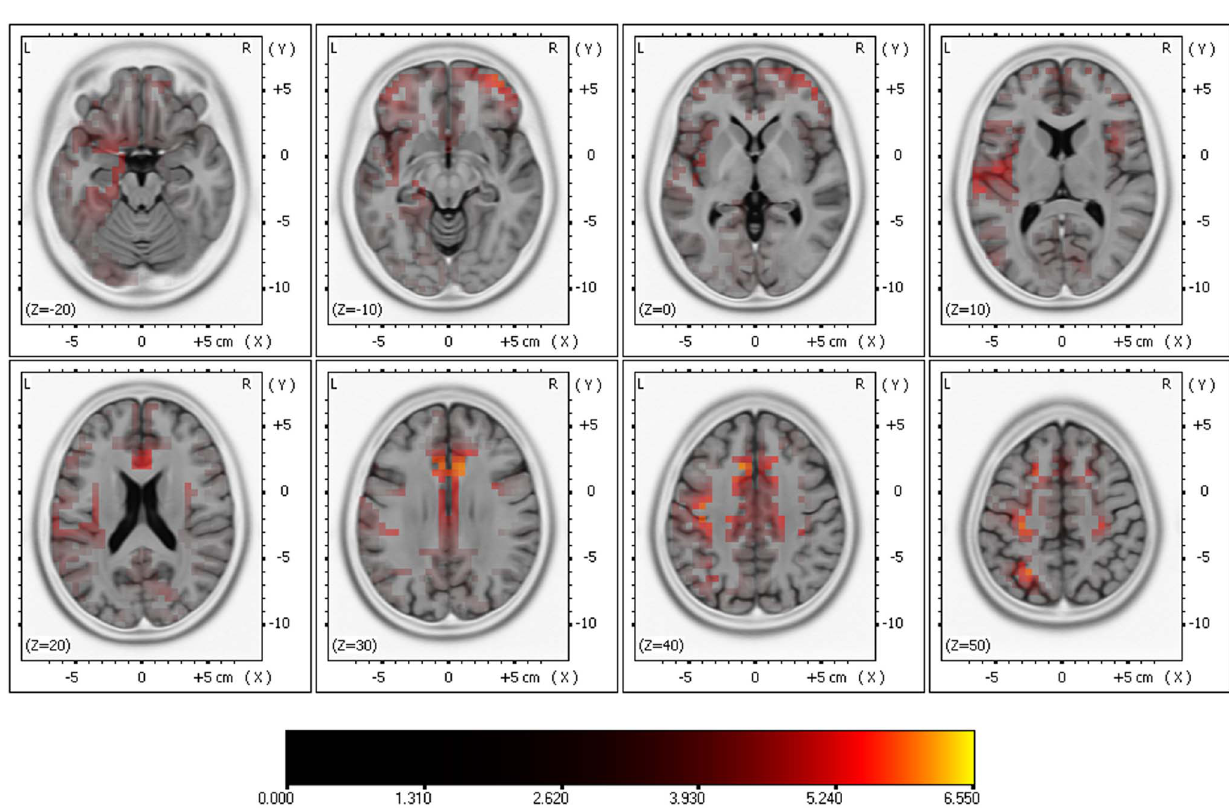
Figure 2. Results of comparing high vs. low SPLs in the source localization anaylsis using sLORETA. Significant differences (two-tailed, p , 0.05) at 140 – 280 ms post-stimulus.